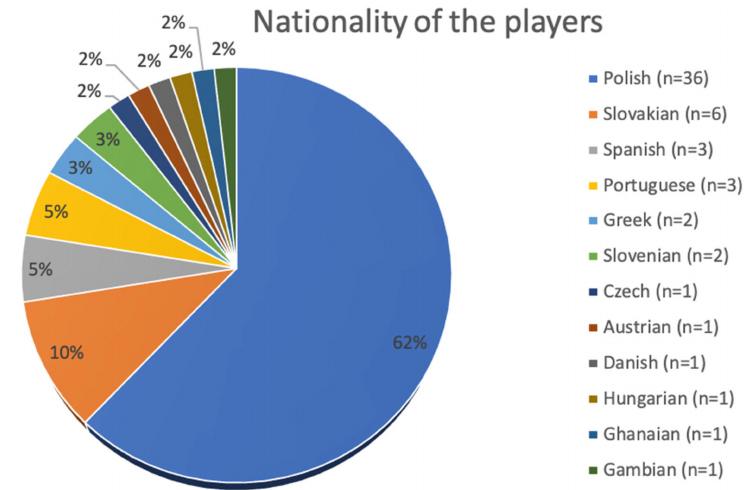
Figure 2. Nationality of the players included in the